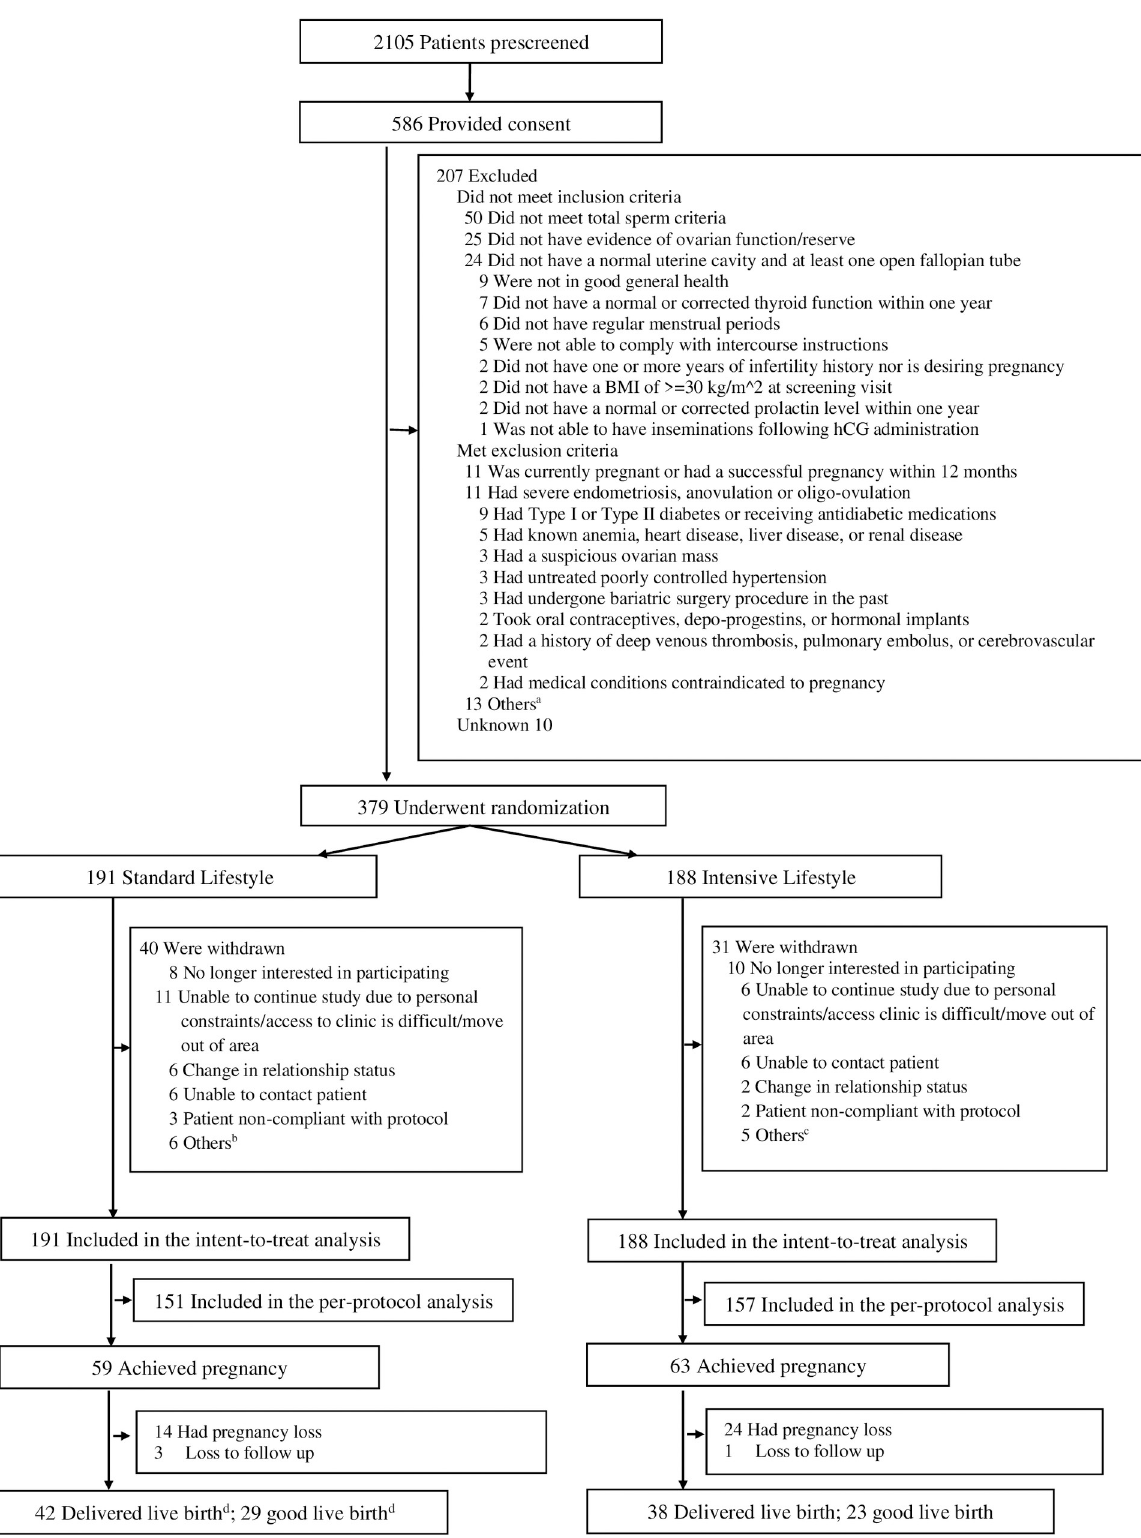
Fig 1. Flowchart: Enrollment and outcomes of the trial. a One had a history of or suspected cervical/endometrial/or breast carcinoma; 1 had known Cushing disease, known or suspected adrenal or ovarian secreting tumors, or a history of gout; 1 had a history of alcohol abuse; 1 had an